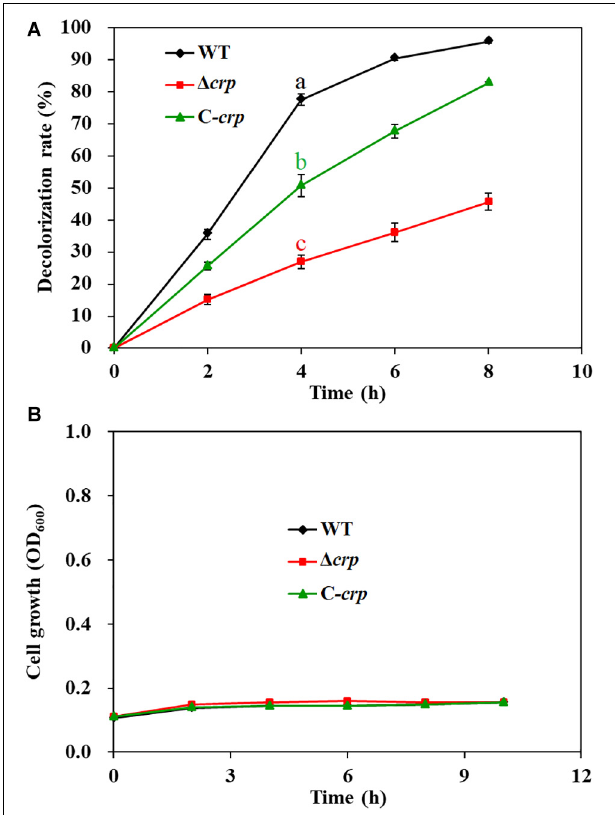
FIGURE 4 | Decolorization of 200 mg/L of AY (A) and cell growth (B) of the WT, (cid:49) cymA mutant, C- cymA mutant, and (cid:49) crp (cid:49) cymA mutant. Values for decolorization and cell growth are means ± SD ( n = 3). The cell growth was determined in the decolorization medium under anaerobic conditions. The decolorization rates of different strains at 4 h were analyzed by ANOVA with the Tukey–Kramer comparison test ( p <